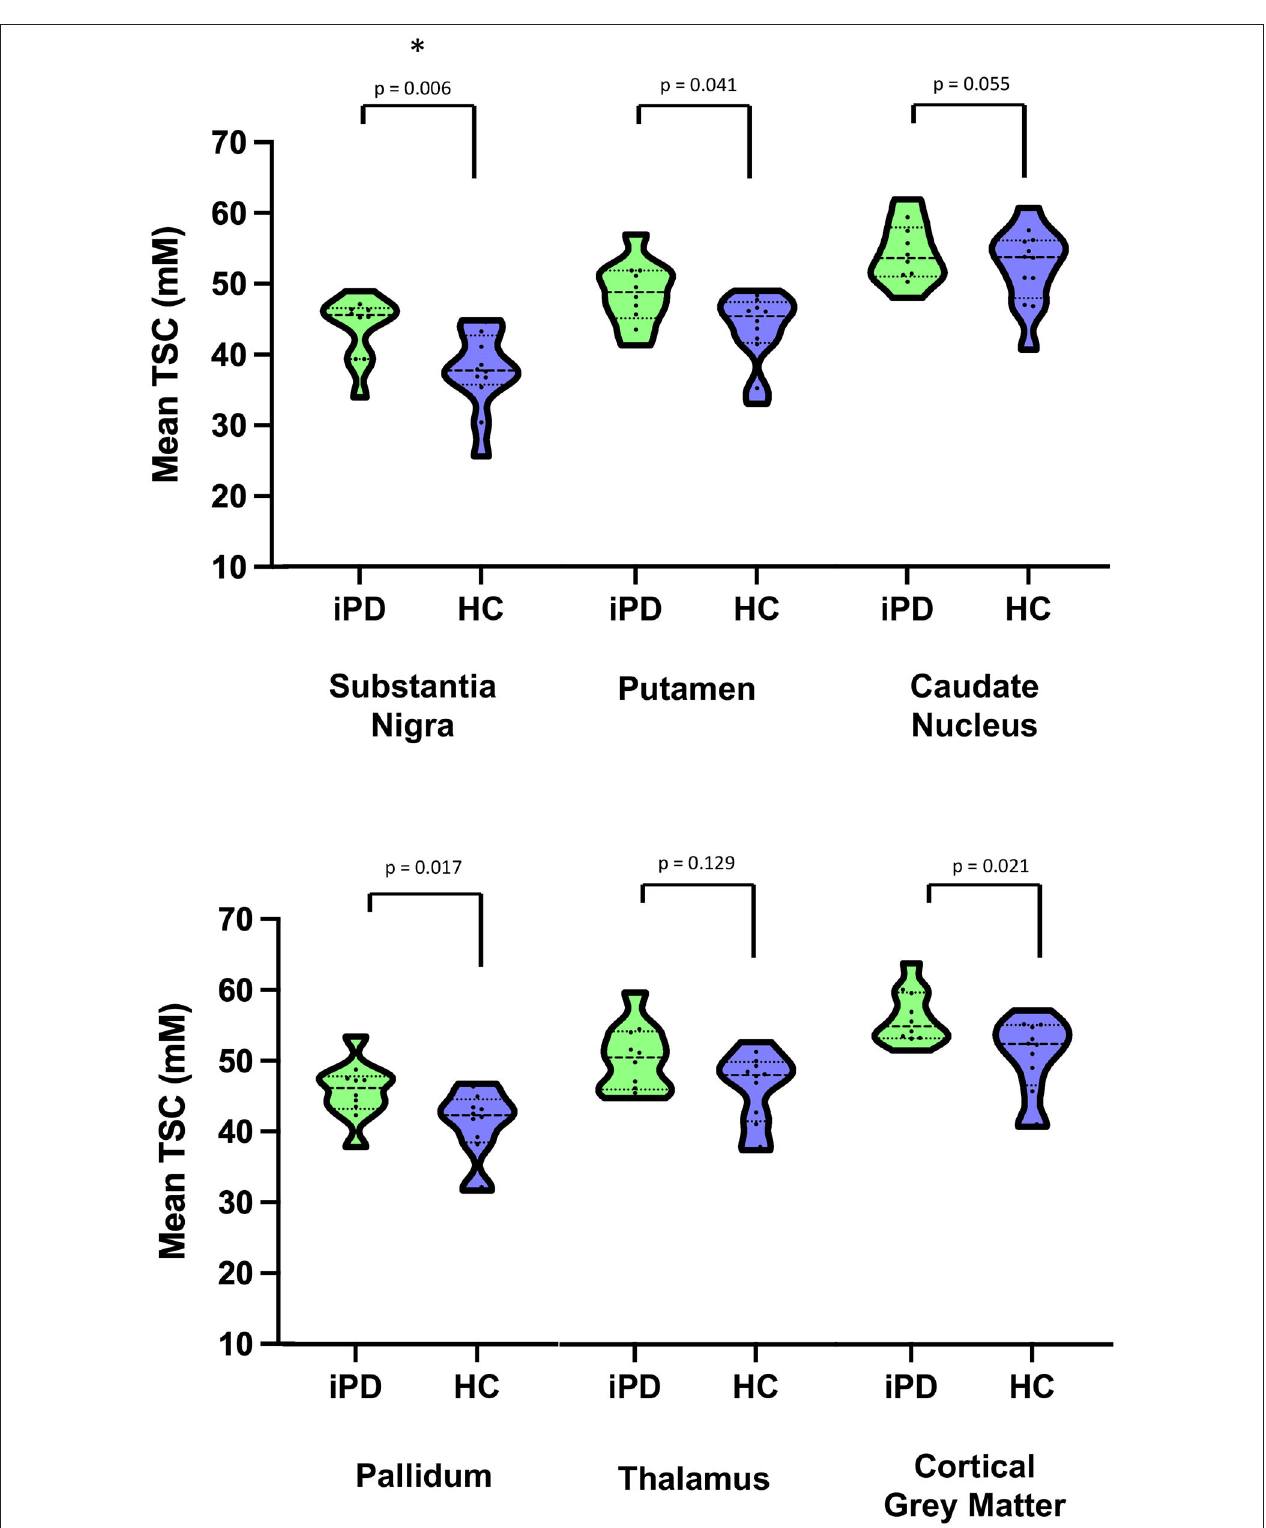
FIGURE 2 | Violin plots of Mean Total sodium concentration (TSC) (wet tissue volume, mmol/l) for iPD and HC. *Survive after multiple comparisons. iPD, idiopathic Parkinson’s Disease; HC, Healthy Controls; TSC, Total sodium concentration.